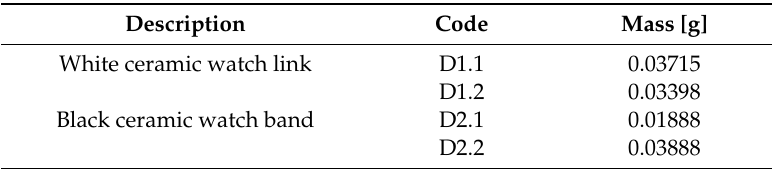
Table 8. Mass of test samples.